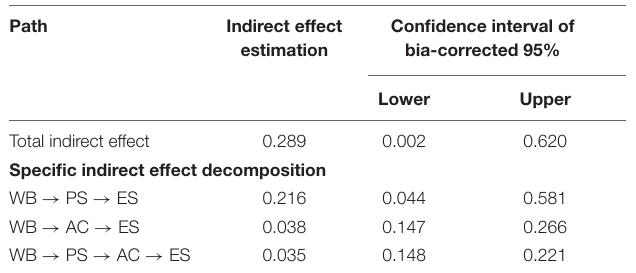
TABLE 3 | Bootstrapping mediation effect test.